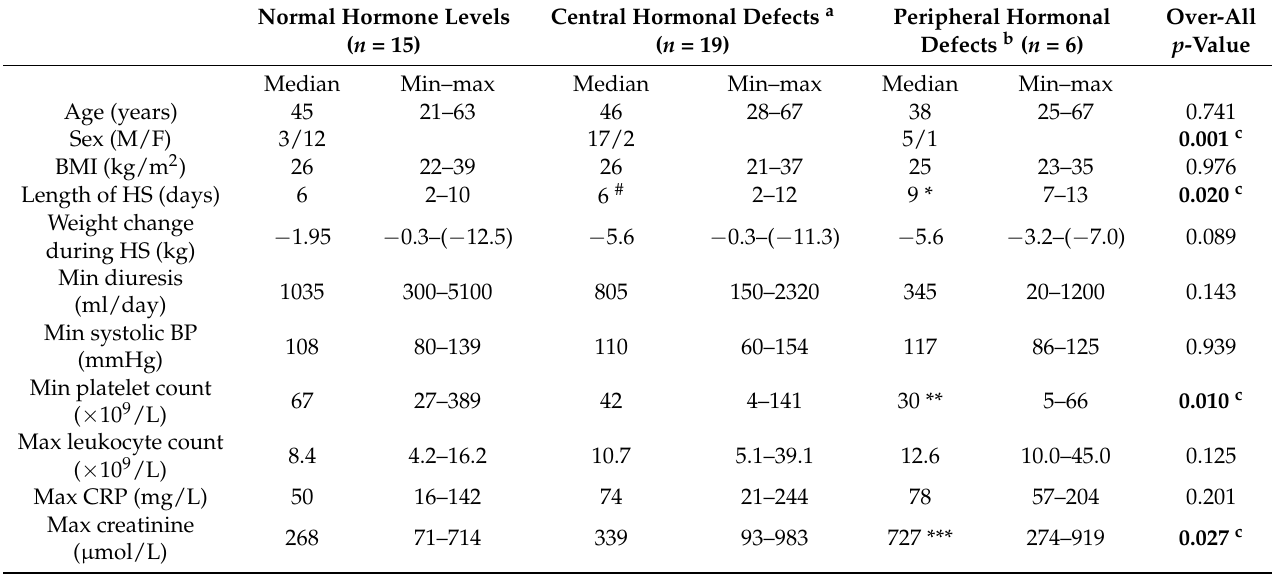
Table 3. Clinical findings during acute Puumala hantavirus infection in patients with normal hormone levels, and in those with overt central or peripheral hormonal defects.